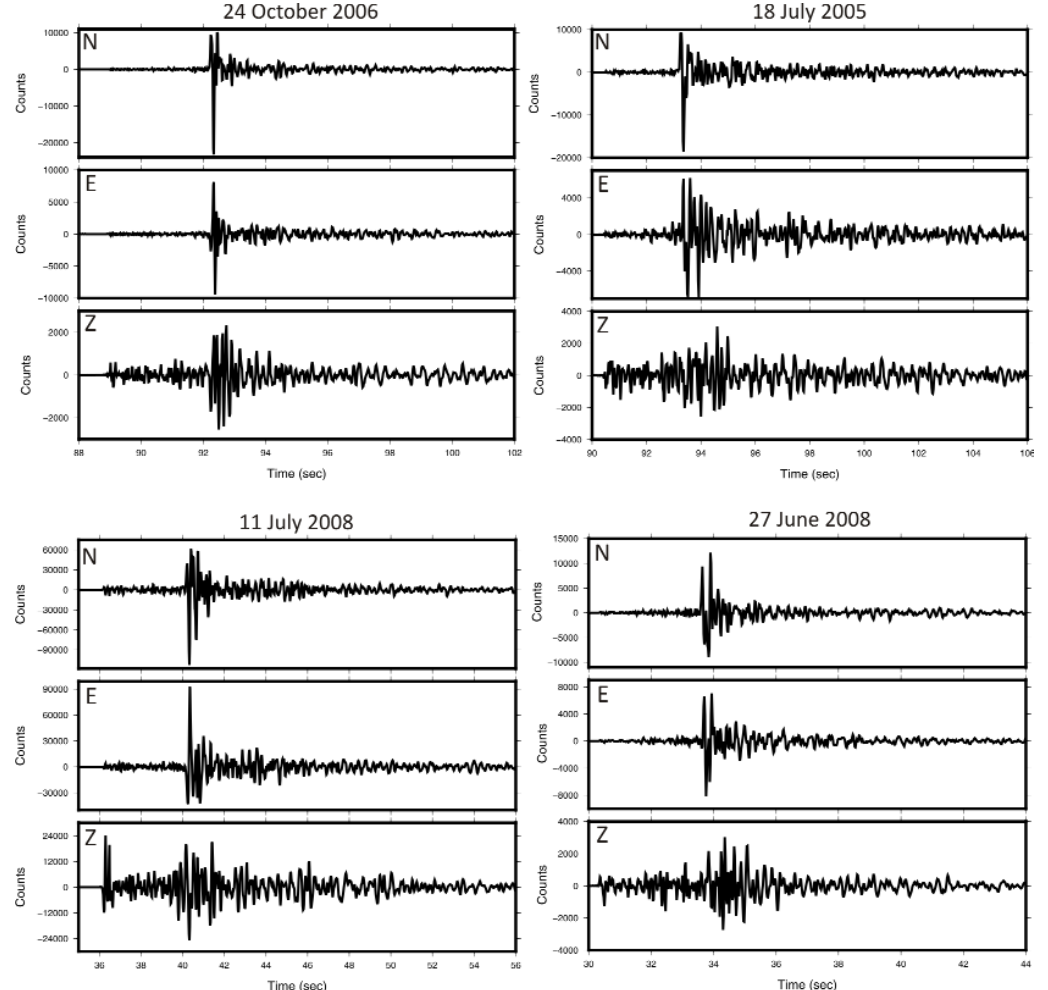
Figure 8. Three-component waveform plots of two pairs of closely located events, as listed in Table 1. The waveforms were band-pass filtered between 1 Hz and 10 Hz, and the event dates are indicated at the